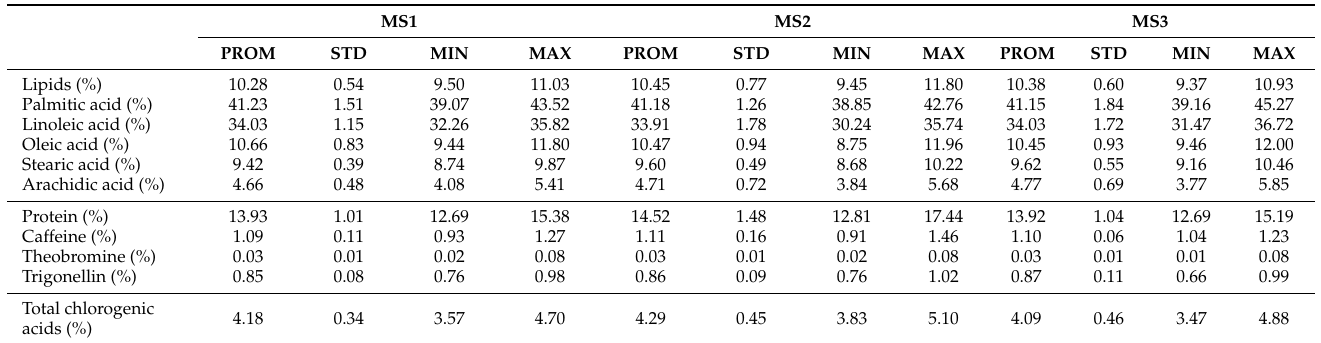
Table 1. * Average contents of lipids, free fatty acids, protein, alkaloids and total chlorogenic acids for three stages of maturity of the coffee